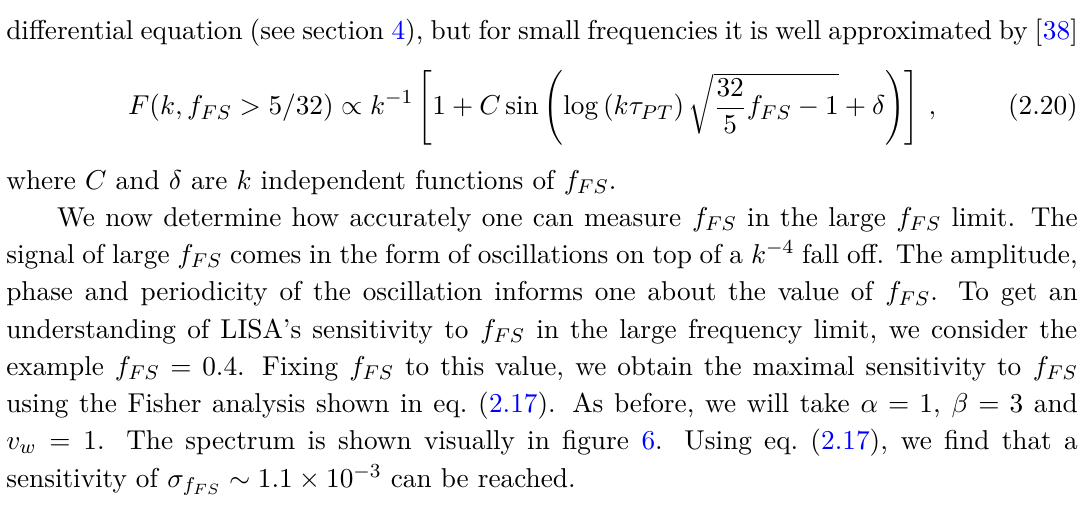
Figure 6 . Ω GW ( f ) versus frequency for a free-streaming fraction of f FS = 0 . 4 . The dashed line indicates the sub-horizon modes, the solid line are the super-horizon modes, and the dotted line is the f 4 fall off on top of which oscillations occur. The small oscillations are what allows one to distinguish between various large values of f FS . For this particular example, a sensitivity of σ f = 1 . 1 × 10 − 3 can be FS